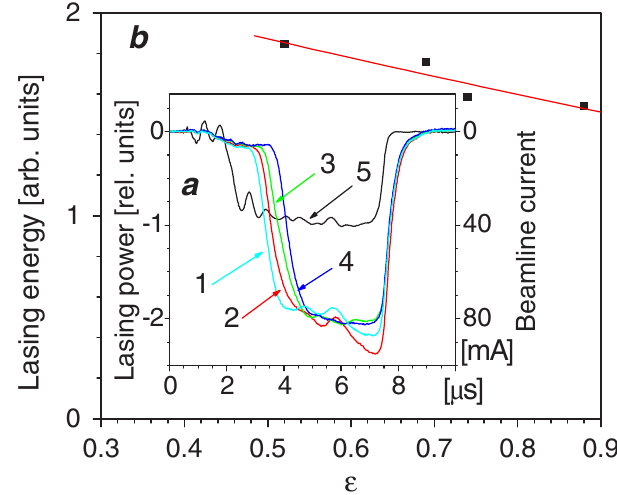
FIG. 12. (Color) (a) Variation of the lasing macropulse shape vs the magnetron-accelerating cavity detuning (left scale). 1— " ¼ 0 : 52 ; 2— " ¼ 0 : 69 ; 3— " ¼ 0 : 74 ; 4— " ¼ 0 : 88 ; 5—shape of the beam line current. (b) Variation of the lasing macropulse energy at wavelength of 110 (cid:1) m vs the detuning parameter.